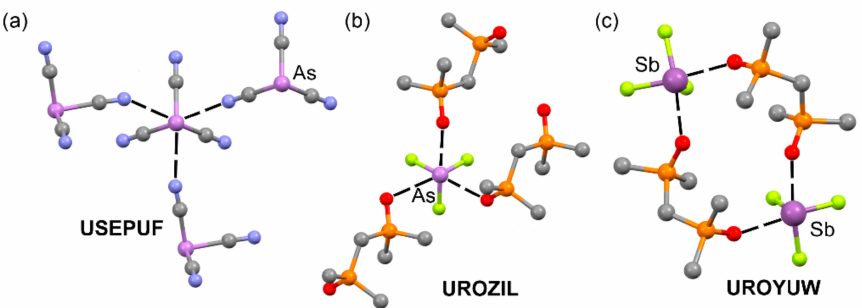
Figure 8. Ball-and-stick representation of the solid-state X-ray structures of USEPUF ( a ), UROZIL ( b ), and UROYUW ( c ) structures. The PnBs are represented using dashed lines. H atoms omitted for